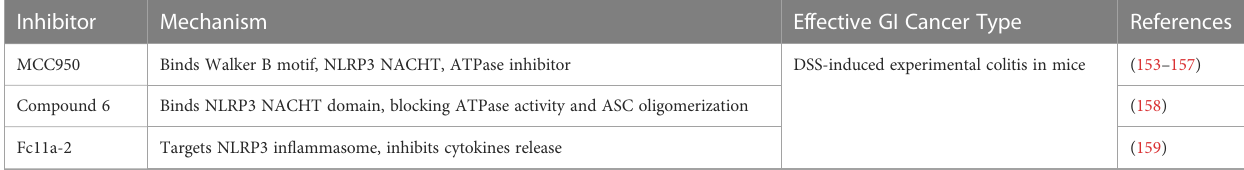
TABLE 1 List of NLRP3 inhibitors. Inhibitor